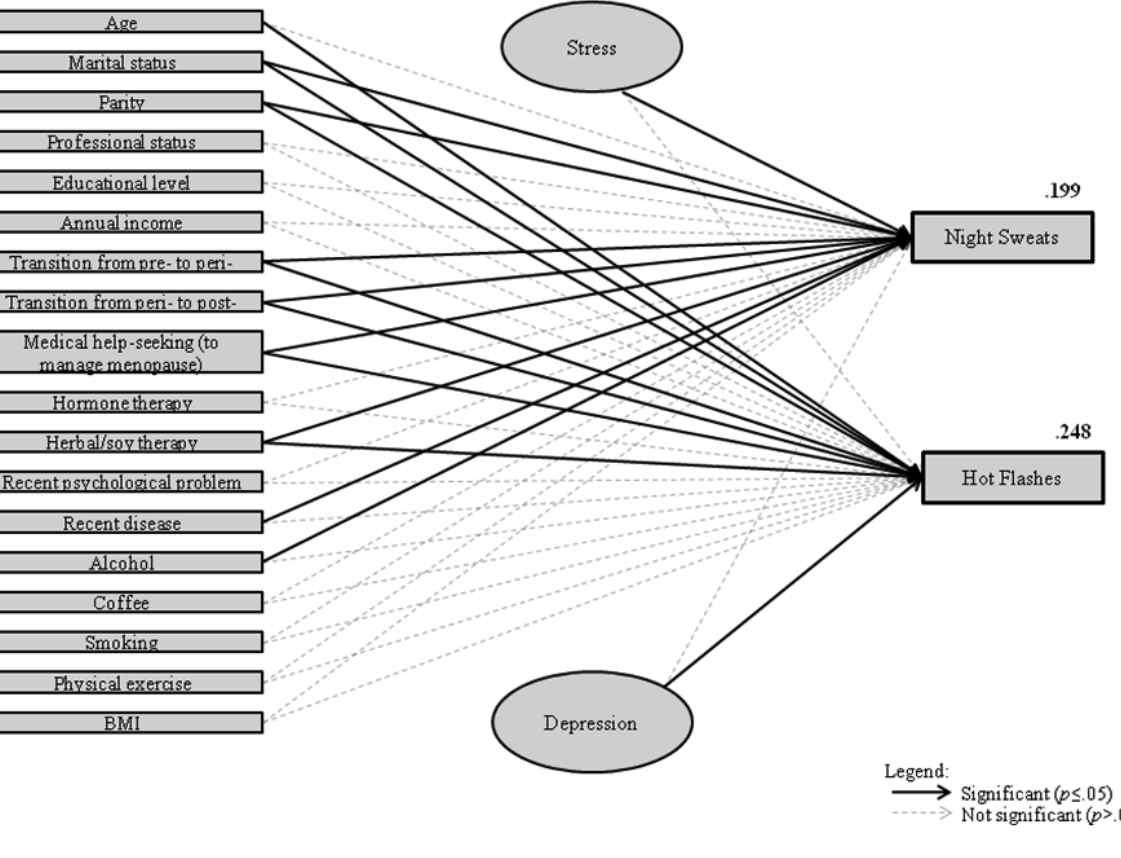
Figure 1 . Causal model of hot fl ushes and night sweats’